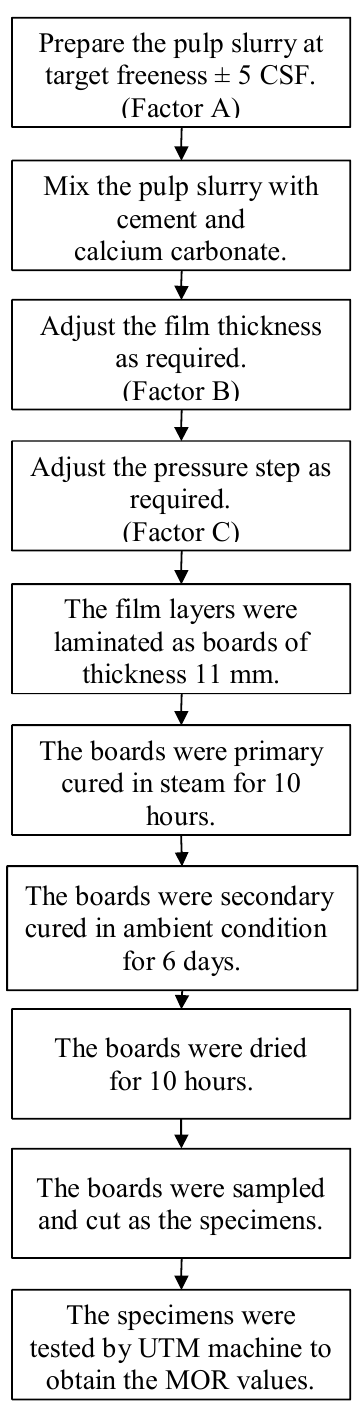
Fig. 4. Process flow of